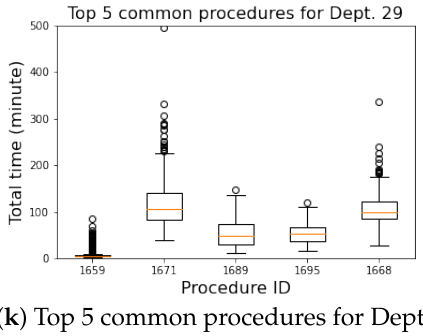
( k ) Top 5 common procedures for Dept. 29 Figure 9. Total time distribution of the top 5 commonly performed procedures for each department.